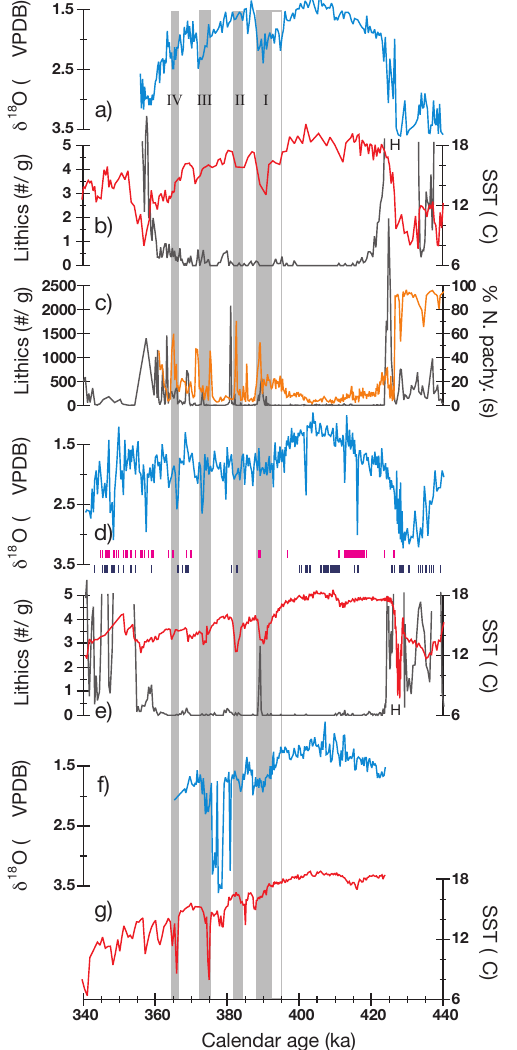
Fig. 6. Close-ups of MIS 11 in the records of IODP Site U1313 ( a and b ), ODP Site 980 (c) , MD03-2699 ( d and e ) and southern Portuguese site MD01-2443 ( f , g ; (de Abreu et al., 2005; Martrat et al., 2007)). G. inflata δ 18 O records are shown in blue (a, d, f), alkenone-based mean annual sea surface temperature (SST) records in red (b, e, g). The abundance of Lithics > 315µm (gray; only sections with < 5 grains/g) are shown for IODP Site U1313 (b) and core MD03-2699 (e) and > 150µm for ODP Site 980 (c; Oppo et al., 1998). Panel c) also includes the % N. pachyderma (s) record of ODP Site 980 (orange; Oppo et al., 1998). In panel d) magenta bars indicate presence of Globorotalia menardii and dark blue ones of Sphaeroidinella dehiscens in the respective levels. MD01-2443 data is shown using the age model of Tzedakis et al. (2009) that links the MD01-2443 benthic δ 18 O data to the EDC δ D record on the EDC 3 timescale (Jouzel et al., 2007) following the approach of Shackleton et al. (2000). Grey bars indicate stadials (numbered I to IV) within MIS 11a. The bar outlined in grey during the oldest stadial marks the interval when cold conditions already prevailed at (I)ODP Sites U1313 and 980. H denotes the Heinrich-type ice- rafting event associated with Termination